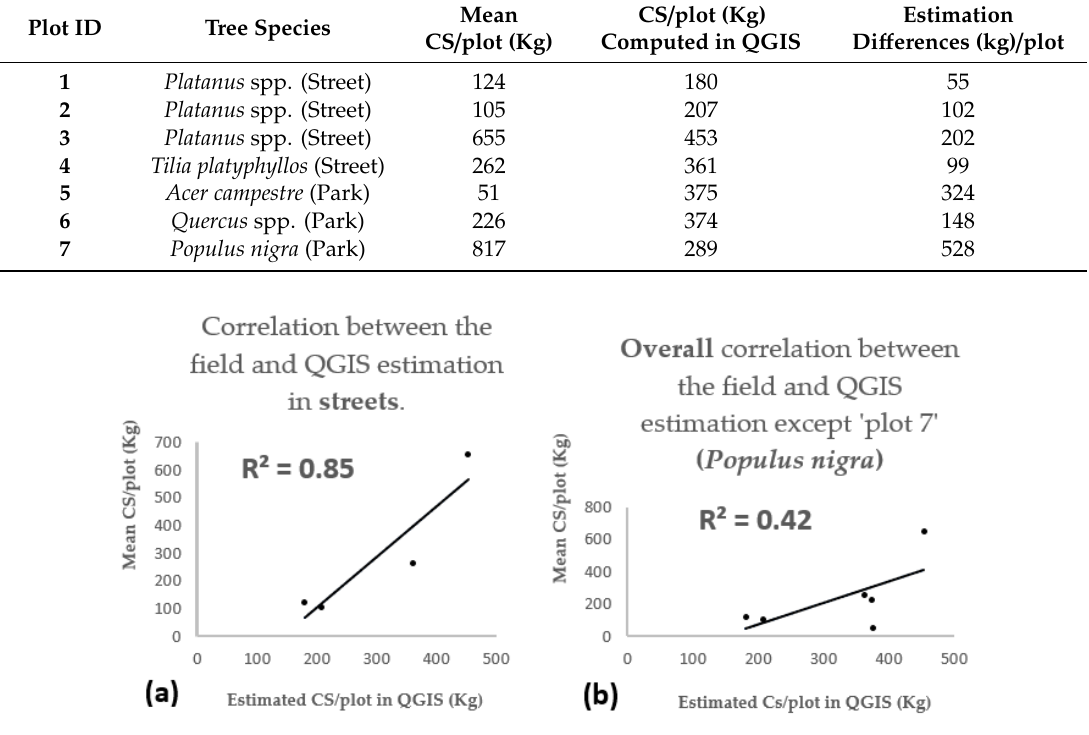
Figure 12. Linear correlation between field estimations and QGIS computations of the CS/plots ( a ) for species on the streets and ( b ) among all the trees except for ‘Populus nigra’ at the validation plots.